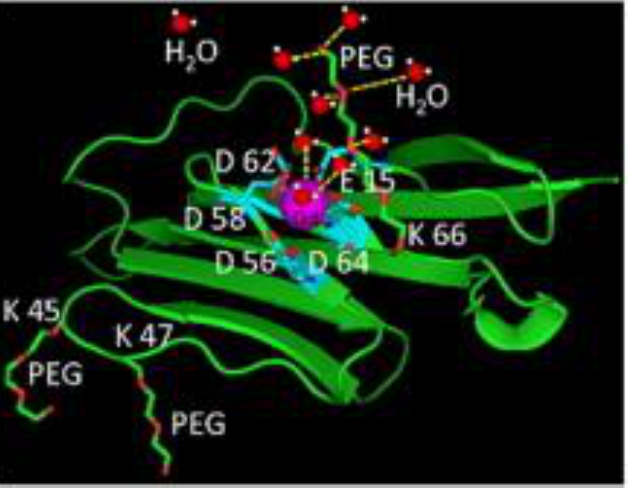
Figure 7. Modelled structure of the coordination of Gd 3+ (purple) in ProCA1 with PEG chain (red), including outer sphere water molecules associated. (D = aspartic acid; E = glutamic acid and K = lysine) Reprinted with permission from Ref. [44] (copyright, 2012,